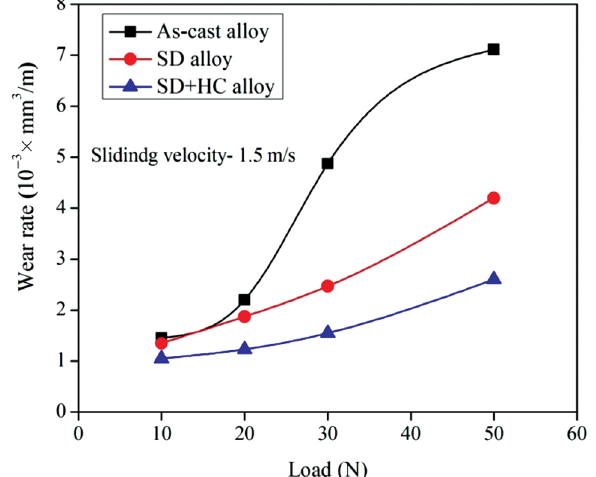
Figure 5: Variation of wear rate with load at sliding velocity of 1.5